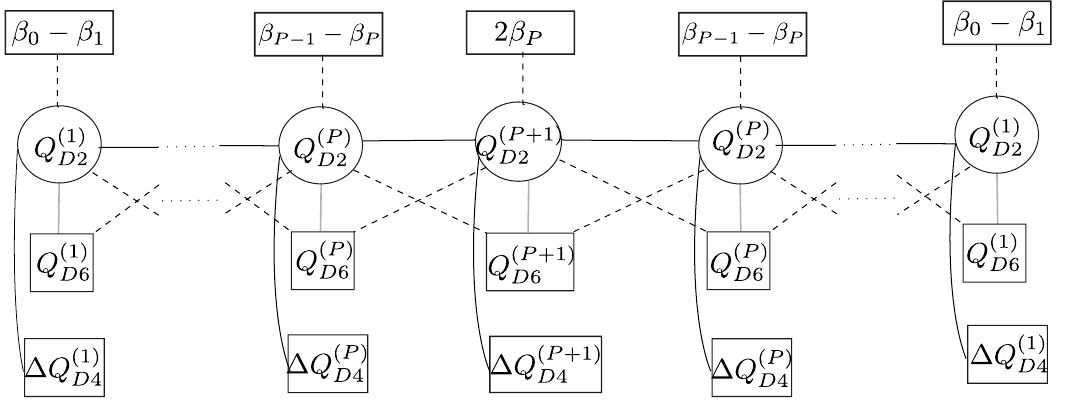
Figure 4 . 2d quivers completed in a symmetric